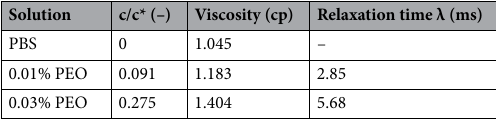
Table 1. Properties of PEO solution.